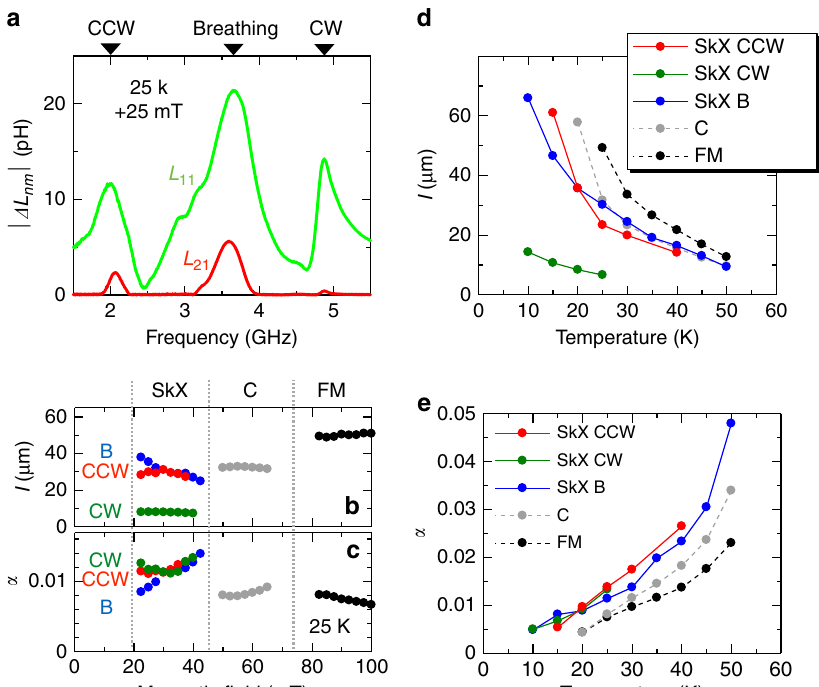
Fig. 4 Decay length and damping parameter associated with the propagation of spin excitations. a Amplitude spectra of self-inductance ∣ Δ L 11 ∣ and mutual inductance ∣ Δ L 21 ∣ measured in the SkX state at 25 K and + 25 mT, whose ratio gives the decay rate of spin excitation amplitude during the propagation. b , c Magnetic fi eld dependence of decay length l and damping parameter α measured at 25 K. d , e Temperature dependence of decay length and damping parameter for various spin excitation